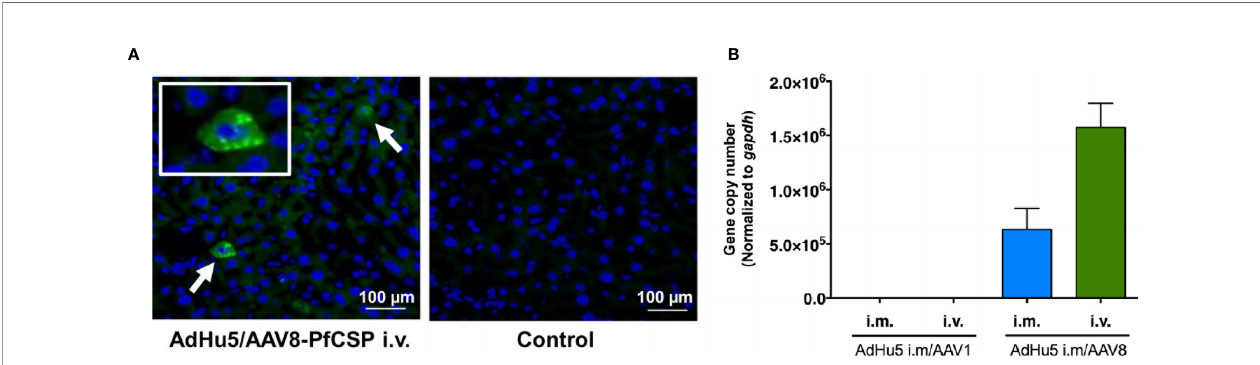
FIGURE 6 | PfCSP expression pro fi les in the livers of the protected mice. Mice were primed with i.m. AdHu5-PfCSP (5.0 × 10 7 pfu/mouse) and boosted with AAV- PfCSP (1.0 × 10 11 vg/mouse) followed by a challenge with 500 PfCSP-Tc/Pb sporozoites. Whole livers were obtained from the protected mice in the challenge study. (A) Immunohistochemistry was performed on the liver microsections with 2A10 mAb followed by Alexa 488-conjugated anti-mouse secondary antibody (green). ( A , left panel) Arrows show PfCSP-expressing hepatocytes. ( A , right panel) As a negative control, a liver section from the same mouse was incubated with the solution without the mAb. Nuclei were simultaneously stained with DAPI (blue). (B) Quantitation of the pfcsp gene in the livers collected from the protected mice in the challenge experiments. The pAAV-CMV-sPfCSP2-(G+) plasmid was used to generate a standard curve with which to determine the pfcsp copy number in the liver. The mouse gapdh gene was used for normalization. ‘ i.m. ’ and ‘ i.v. ’ indicate the route of booster immunization with AAV1 or AAV8 following AdHu5 i.m.